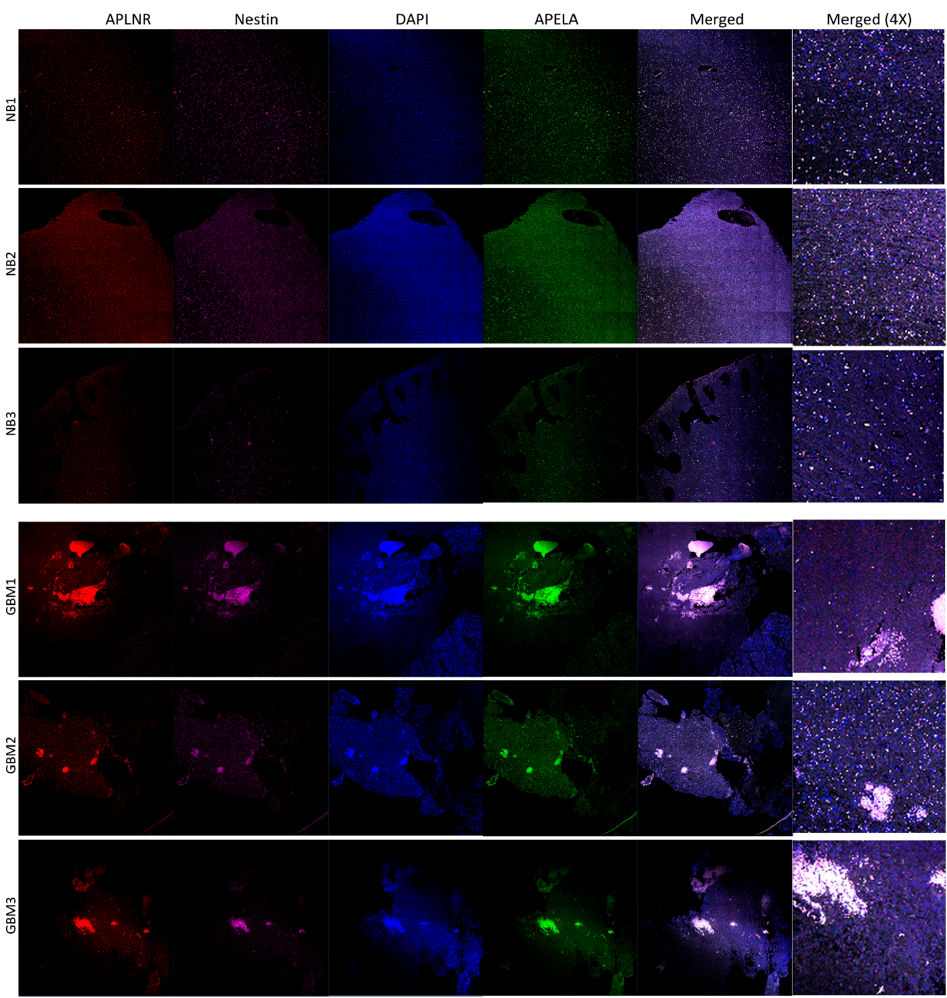
Figure 4. APELA is co-expressed with the stem cell marker Nestin at the mRNA level in GBM tumor